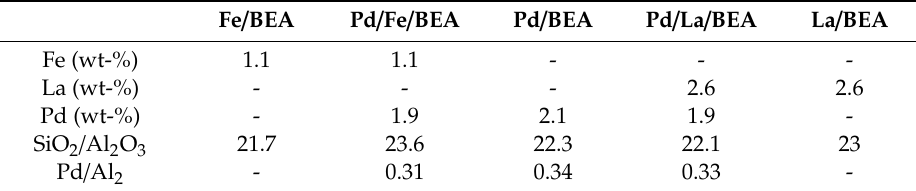
Table 1. ICP-SFMS results for the prepared powder samples.